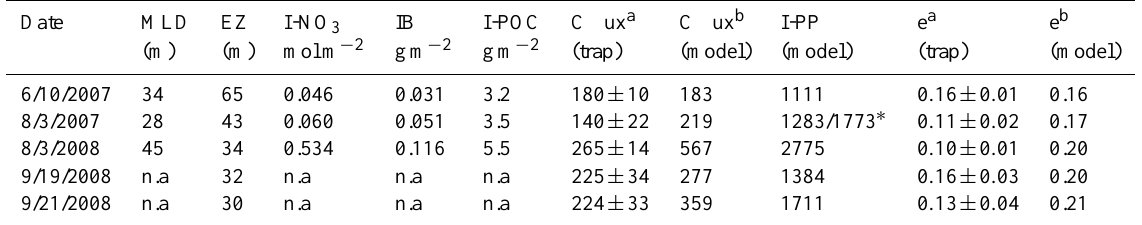
Table 1. Data of mixed layer depth (MLD), euphotic zone (EZ: 1% of surface light intensity), integrated nitrate (I-NO 3 ) , chl- a (IB), POC (I-POC) and POC flux from different